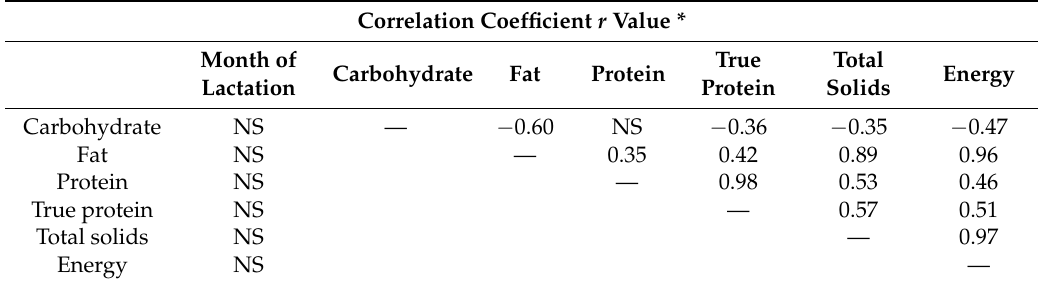
Table 4. Correlations among macronutrients during lactation over 24 months.